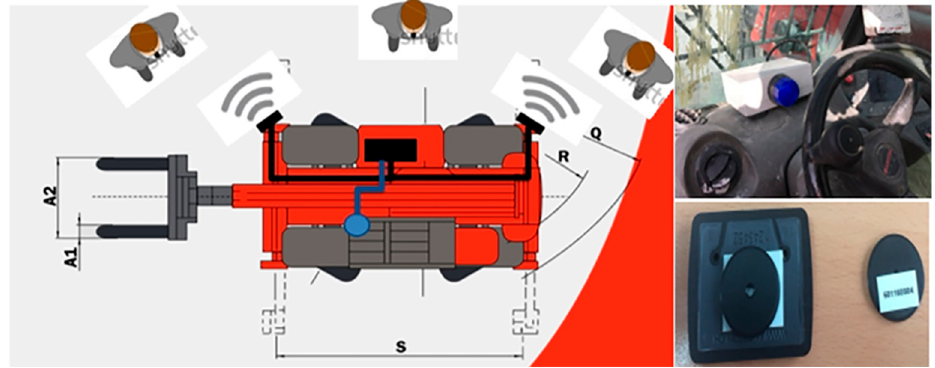
Figure 4. Application of radio-frequency tag-based system, with details of cabin alarm (top right) and the tag/badge wearable by workers (bottom right).